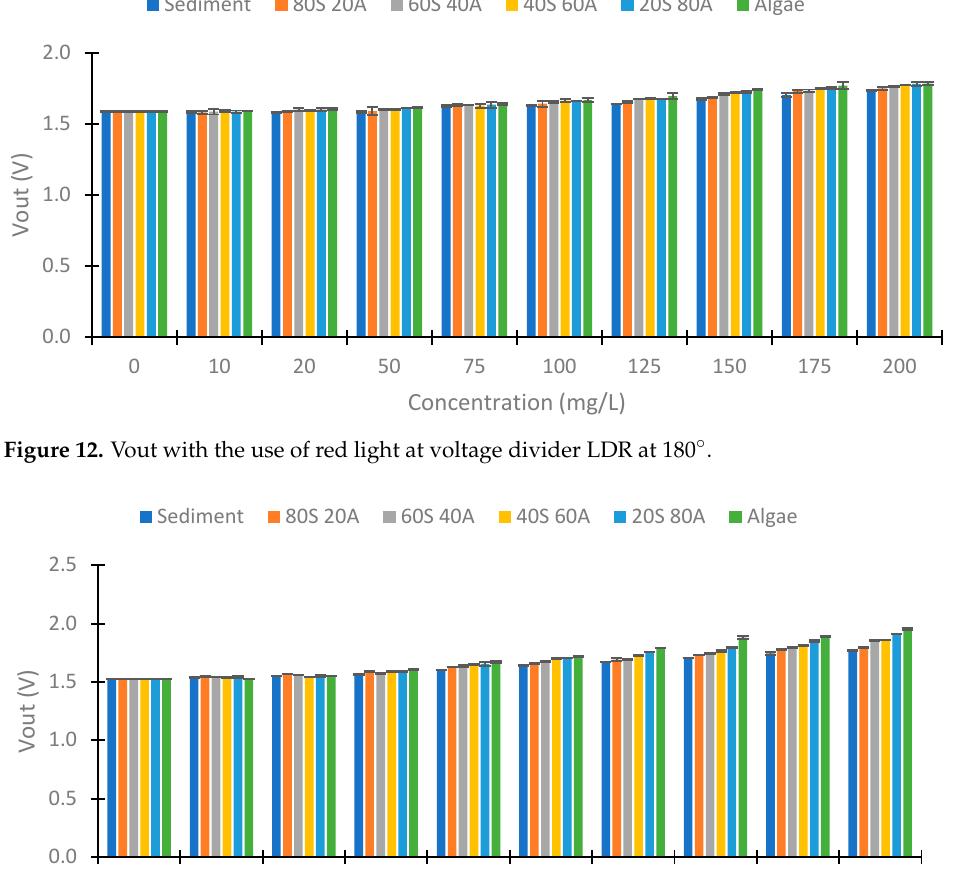
Figure 13. Vout with the use of green light at voltage divider LDR at 180 ◦